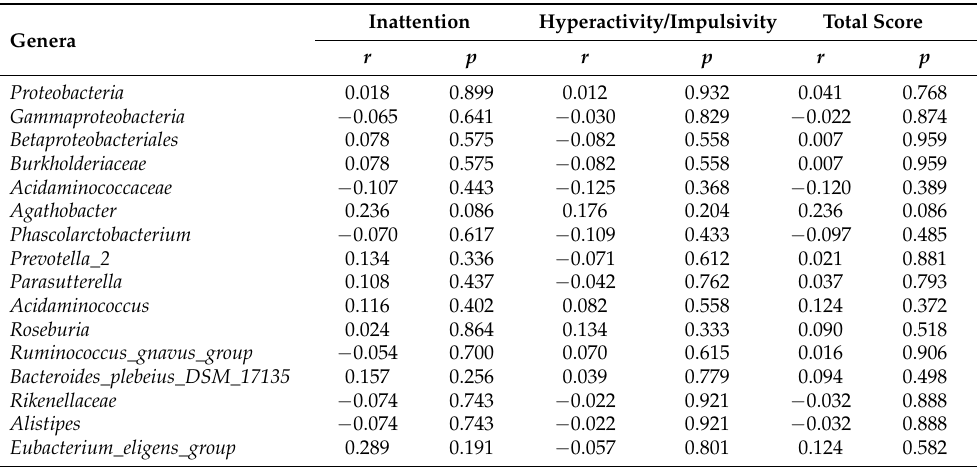
Table 2. The correlation between relative abundance of microbiota and clinical symptoms of attention- deficit/hyperactivity disorder (ADHD) according to